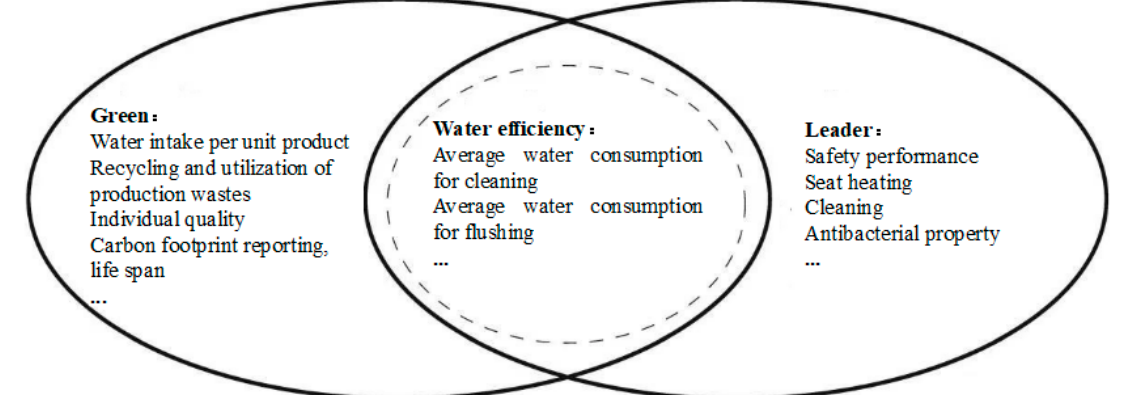
Figure 4. Example of evaluation system of smart water closets.